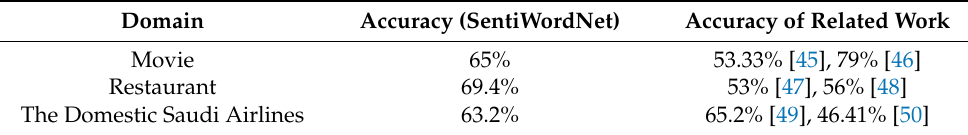
Table 4. The performance of the proposed model and standard model across three domains.